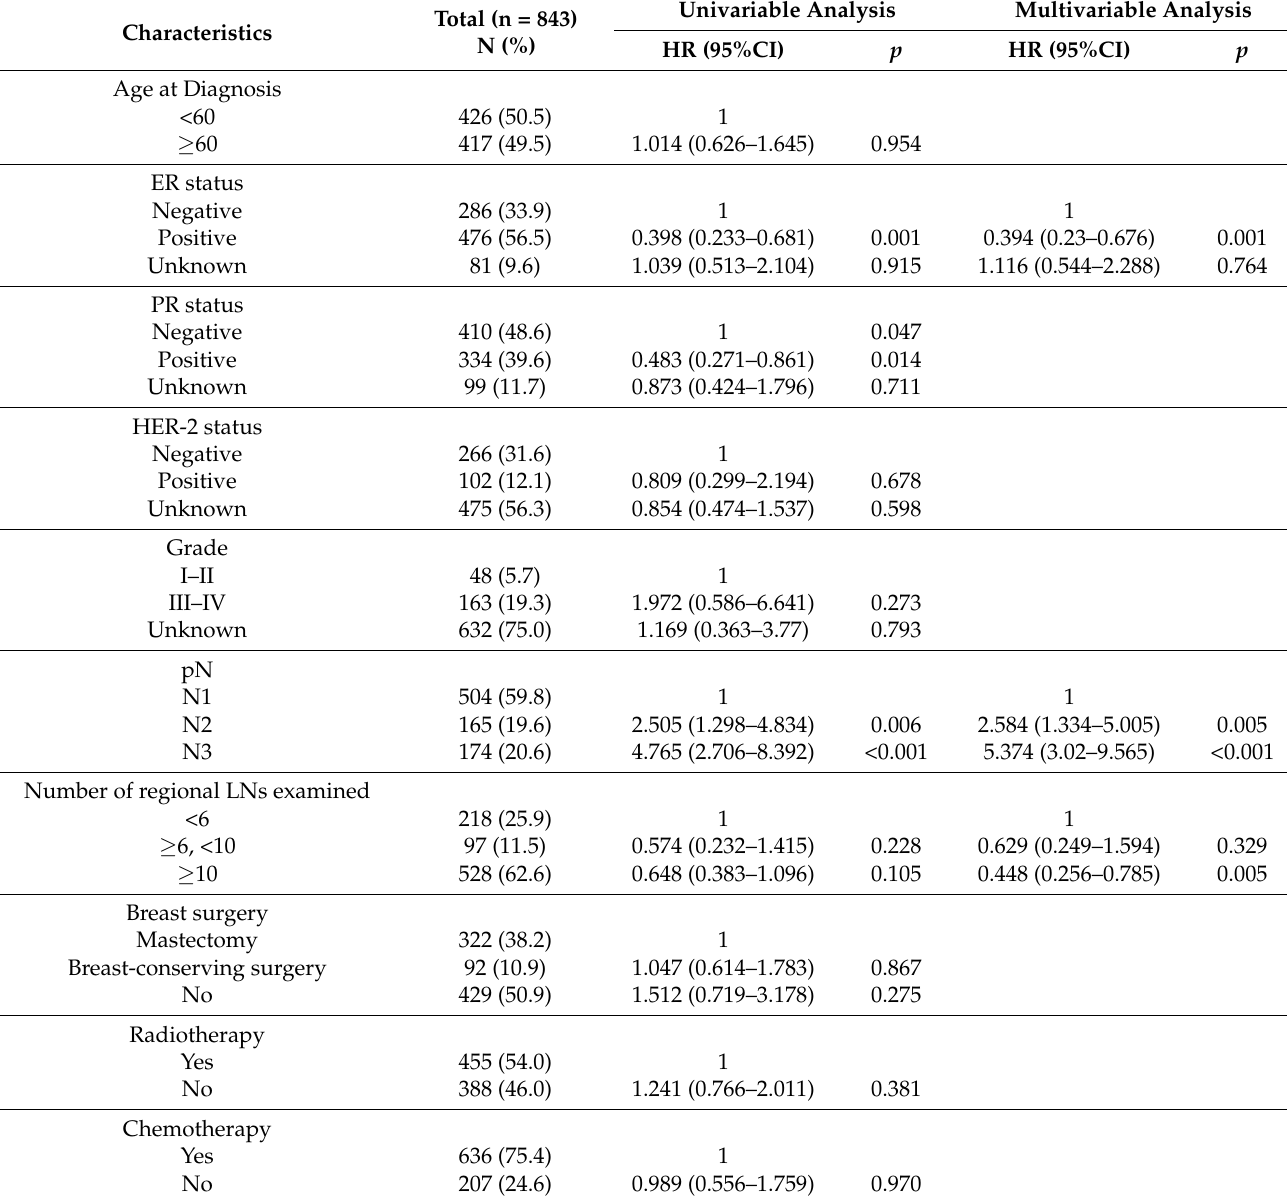
Table 1. Patient